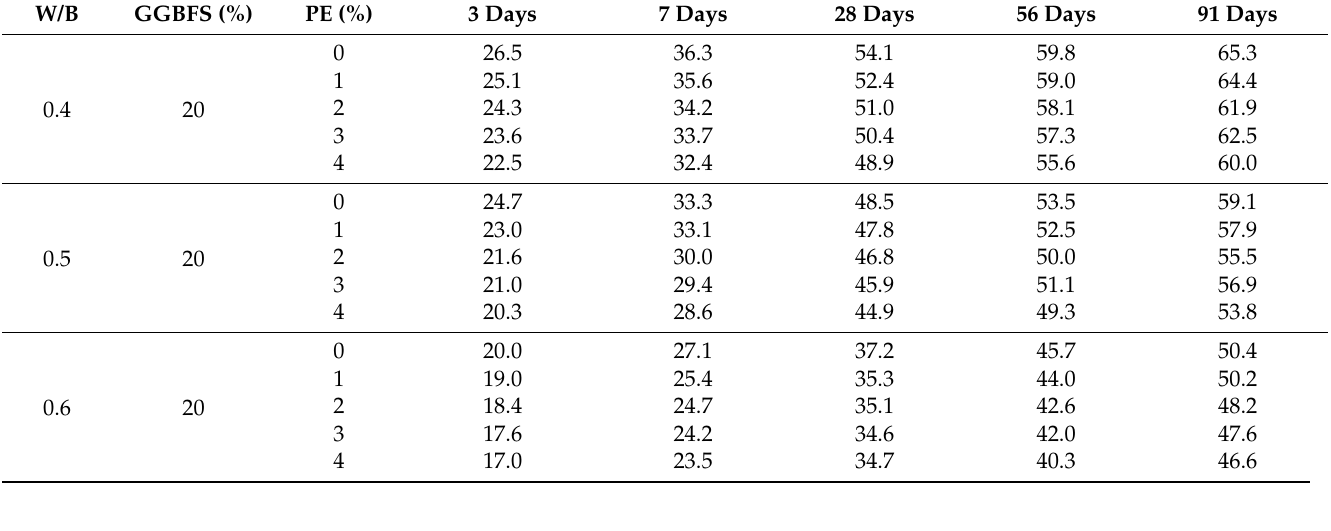
Table 7. Compressive strength of cement mortar with different W/B ratios and waste PE (unit: MPa).